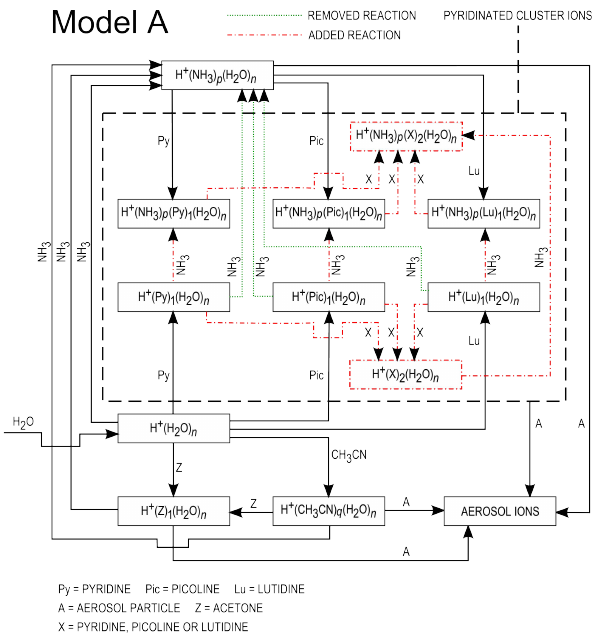
Fig. 1. Tropospheric cluster ion reaction scheme used in Model A. Dotted lines represent reactions removed from the model employed by Beig and Brasseur (2000). Dashed-dotted lines represent reac- tions not included in the model by Beig and Brasseur (2000).